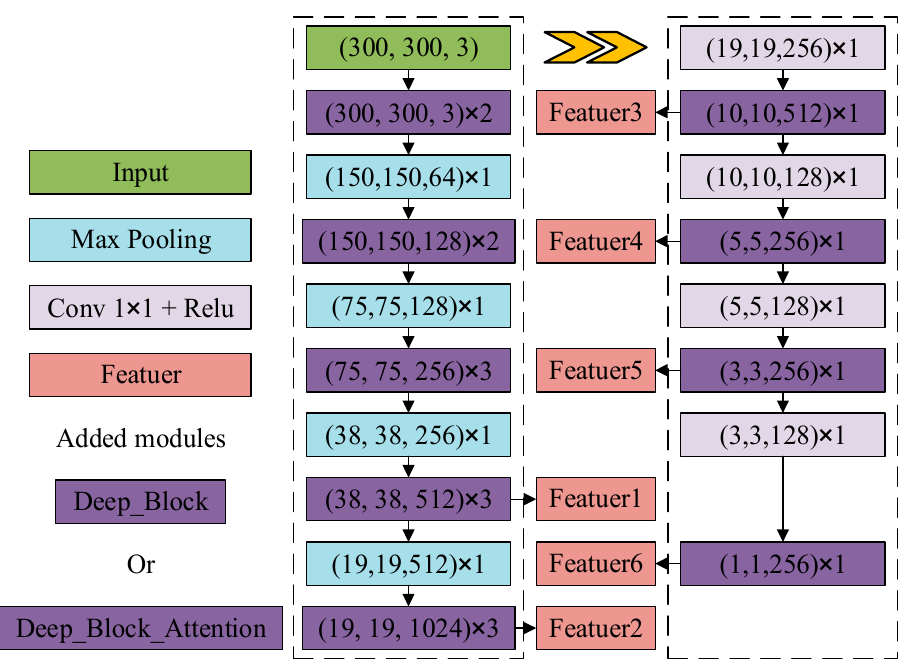
Figure 6. DBA_SSD network structure.